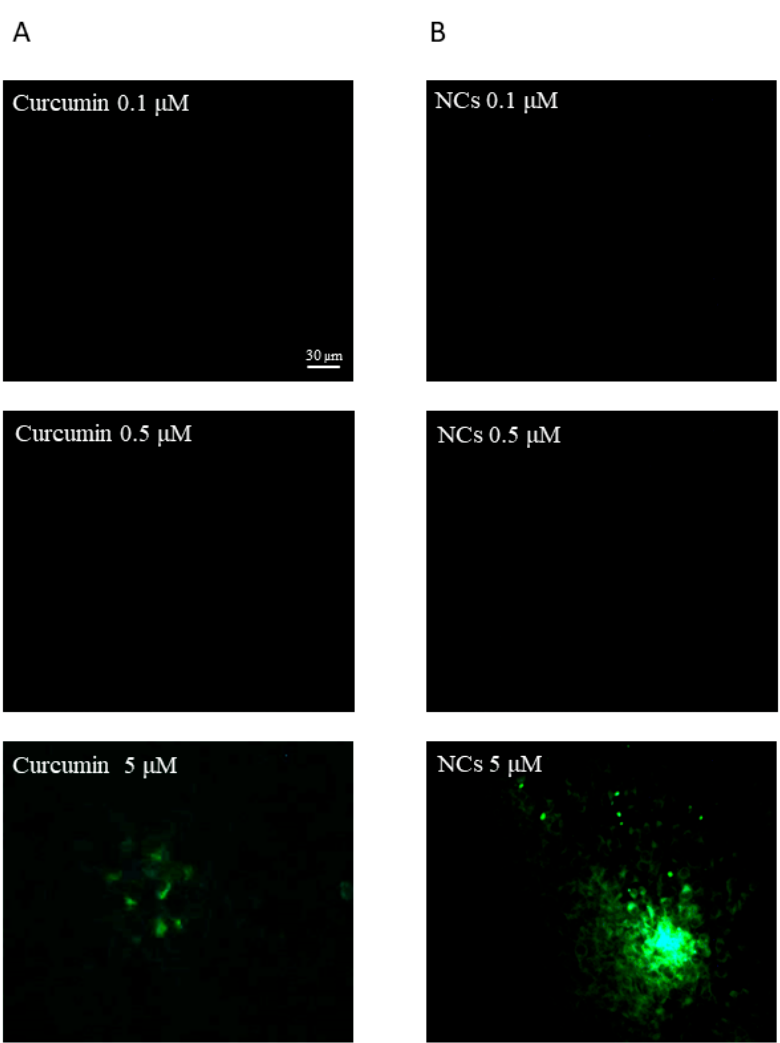
Figure 7. The internalization and uptake of curcumin ( A ): 0.1 µM; 0.5 µM; 5 µM; and Curcumin NCs ( B ): 0.1 µM; 0.5 µM; 5 µM into OECs. Scale bar: 30 µm. ( B ): 0.1 µ M; 0.5 µ M; 5 µ M into OECs. Scale bar: 30 µ